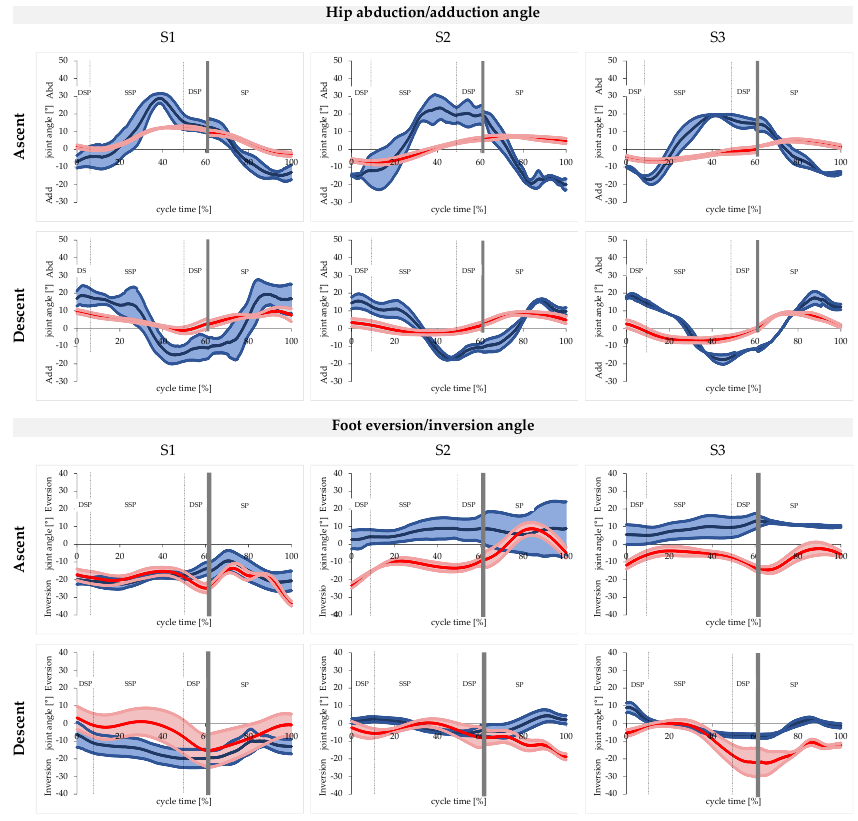
Figure 7. Foot and hip angle curves in the frontal plane for ascent and descent without (red) and with (blue) the exoskeleton for Subject 1 ( left ), Subject 2 ( middle ), and Subject 3 ( right ); DSP = double stance phase, SSP = single stance phase, SP = swing